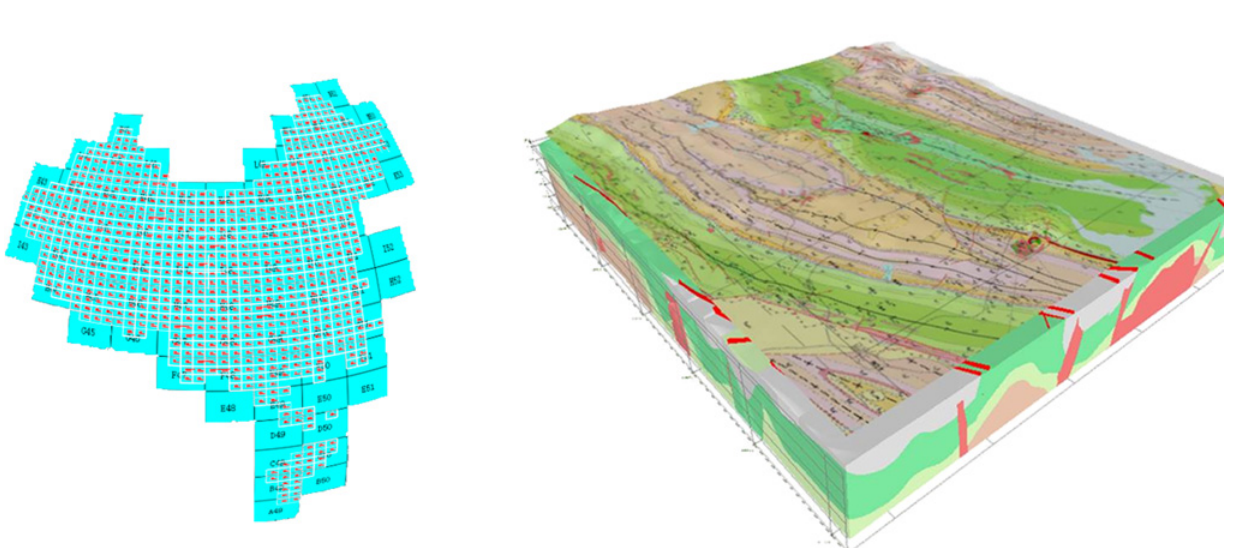
Fig 13. Geological integrated map